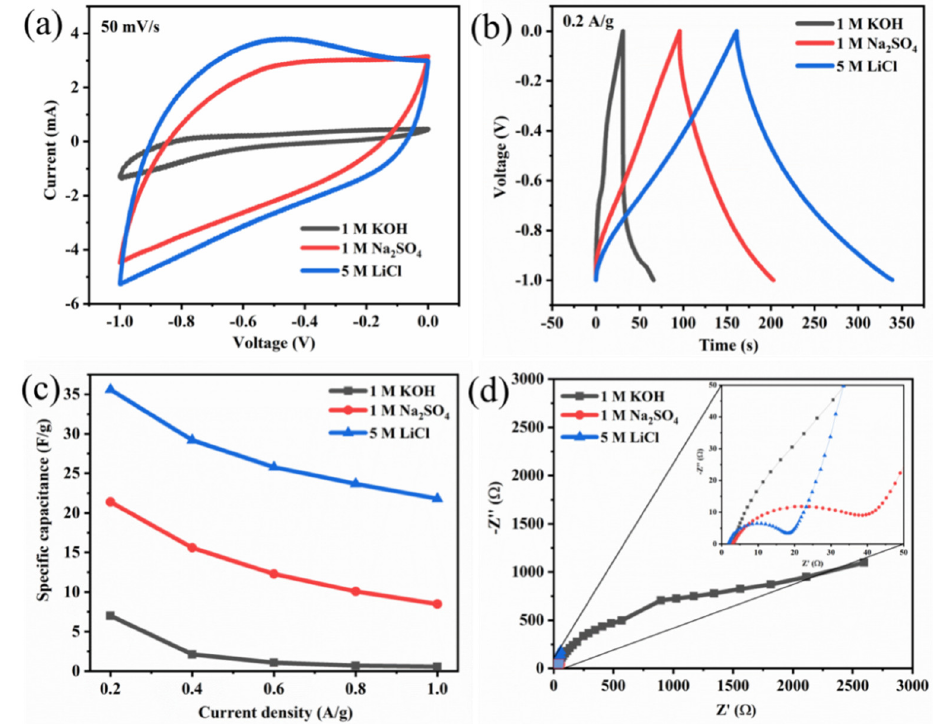
Figure 13. ( a ) CV, ( b ) GCD, ( c ) Cs vs. current density, and ( d ) EIS curves of MXene/Fe 3 O 4 .